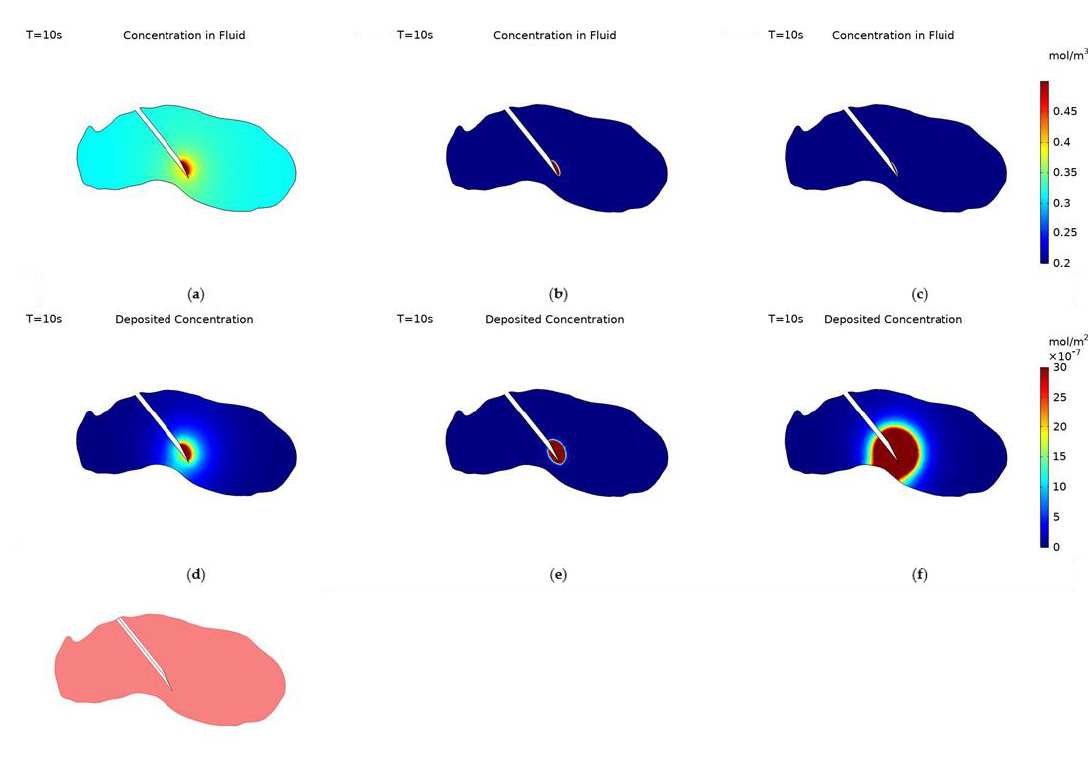
Figure 9. Concentration contours of nanoparticles within the fluid at the end of injection, with surface charge; ( a ) − 30 mV, ( b ) 0 and ( c ) +30 mV, and deposited onto cell surfaces, with surface charge; ( d ) − 30 mV, ( e ) 0 and ( f ) +30 mV, when the needle is placed centrally in the tumour, ( g ) a schematic of the cut-plane used to plot the results. Moving the injection location to the centre of the tumour along the long axis has no effect on the particle volume for uncharged particles, the particles cannot move away from the needle tip due to the low diffusivity and the high rate of deposition on cells and so the